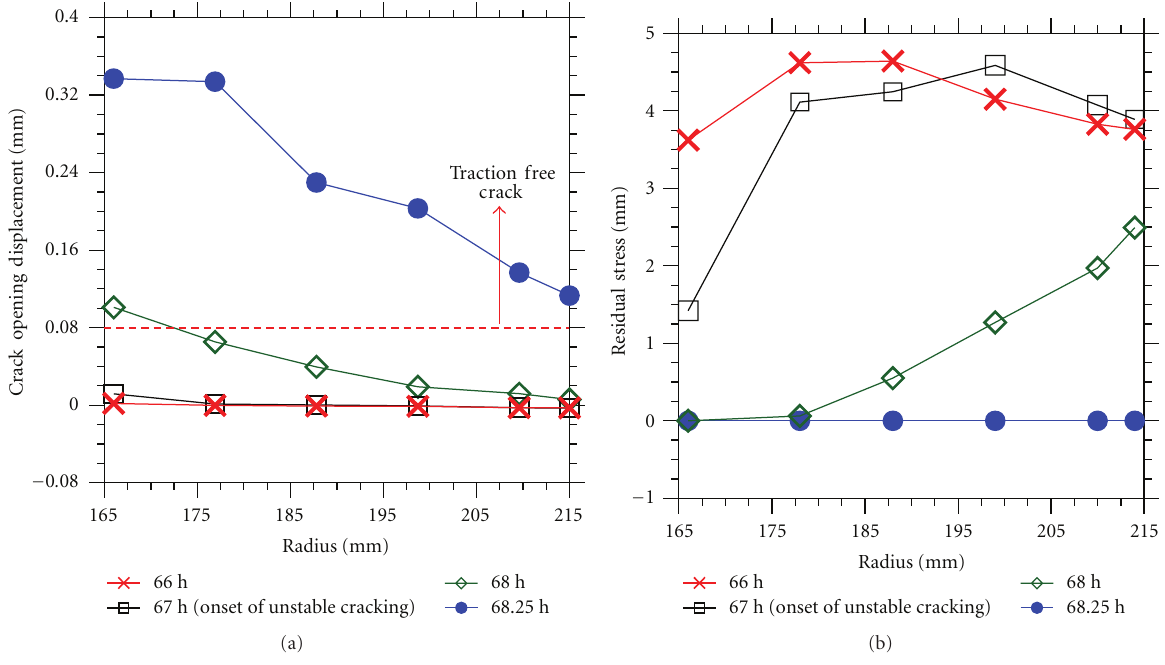
Figure 9: (a) Crack opening displacement and (b) residual stress development through the specimen wall in the damage zone when the elastic modulus was reduced by